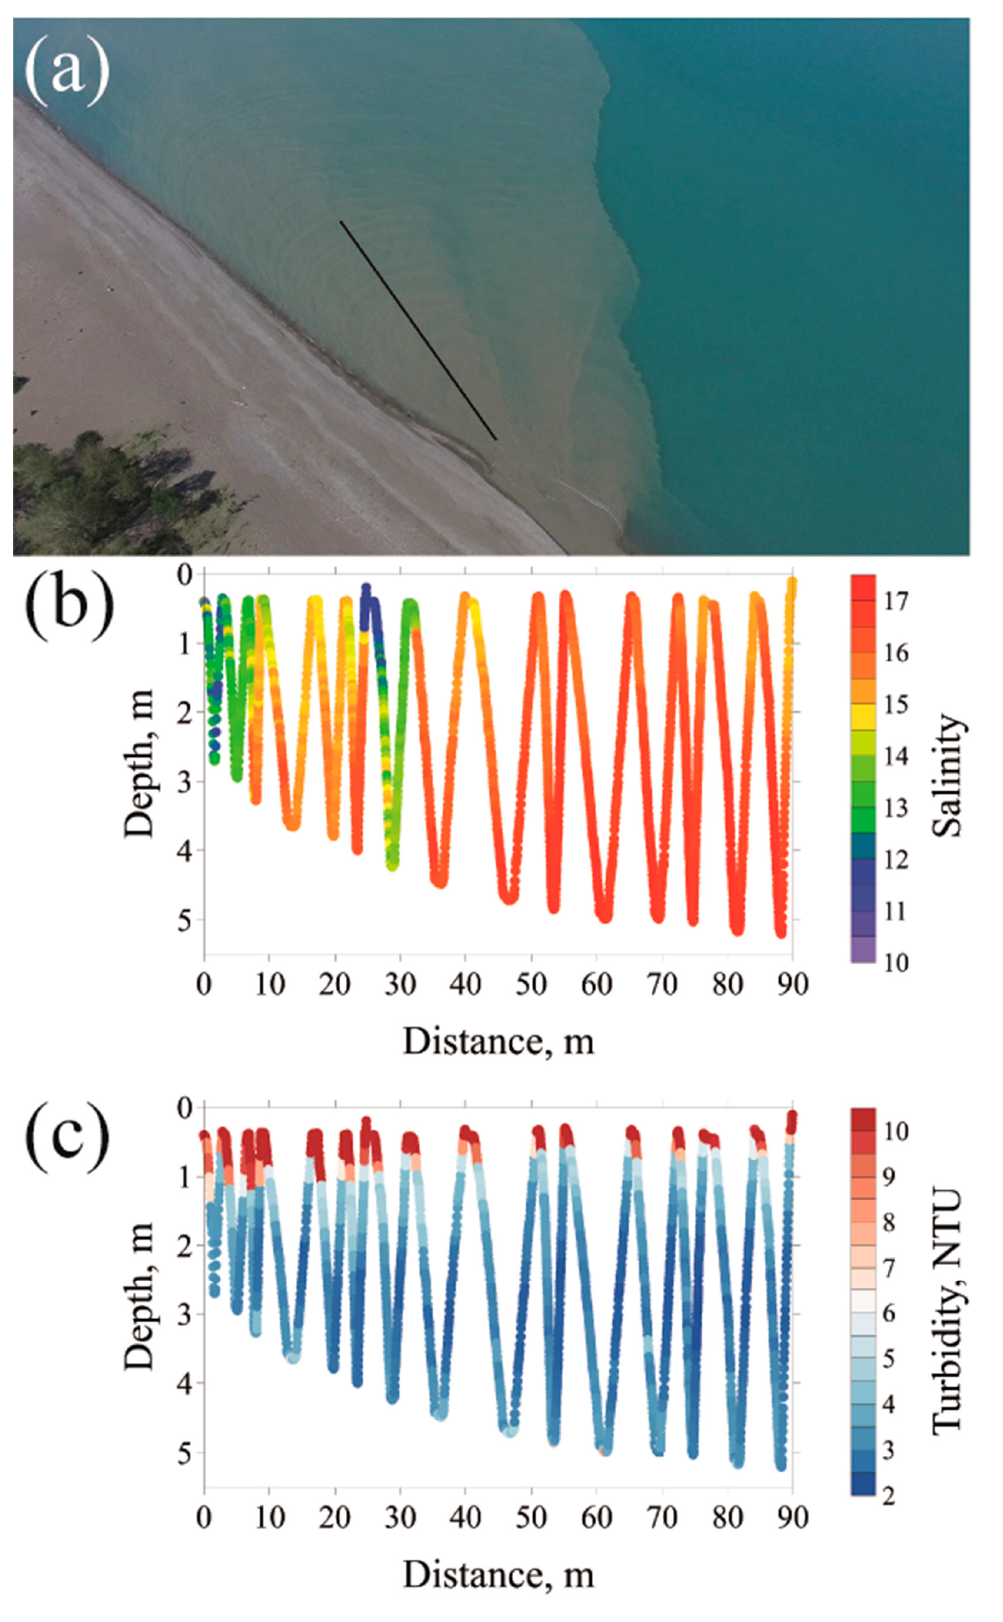
Figure 11. ( a ) aerial image of surface manifestations of internal waves propagating within the Bzyp plume o ff the river mouth and location of the hydrological transect (black line) on 1 July 2019 ( a ). Vertical ( b ) salinity and ( c ) turbidity profiles along the hydrological